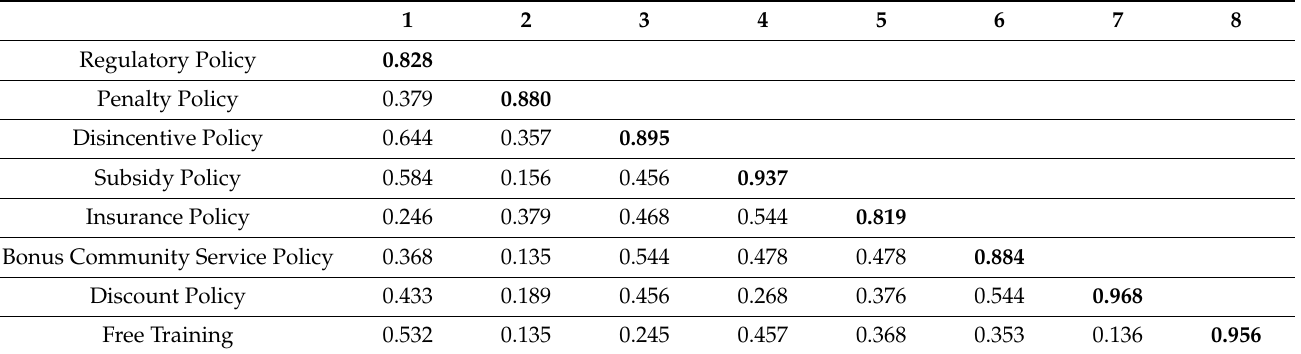
Table 5. Fornell–Larcker criterion for measuring discriminant